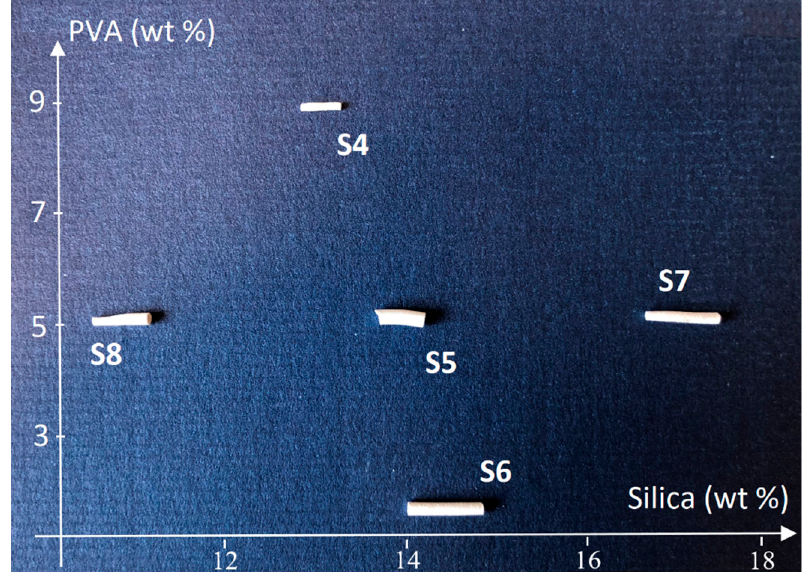
Figure 1. E ff ect of binder composition on the morphology of ZSM-5 extrudates. Figure 1. Effect of binder composition on the morphology of ZSM-5 extrudates.